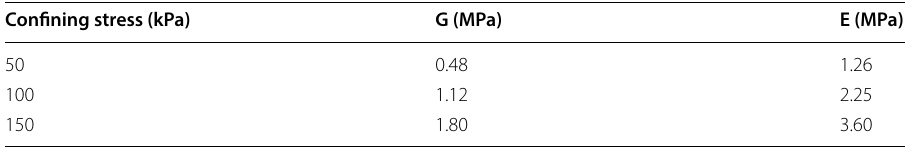
Table 4 The elastic constants obtained from triaxial test Confining stress